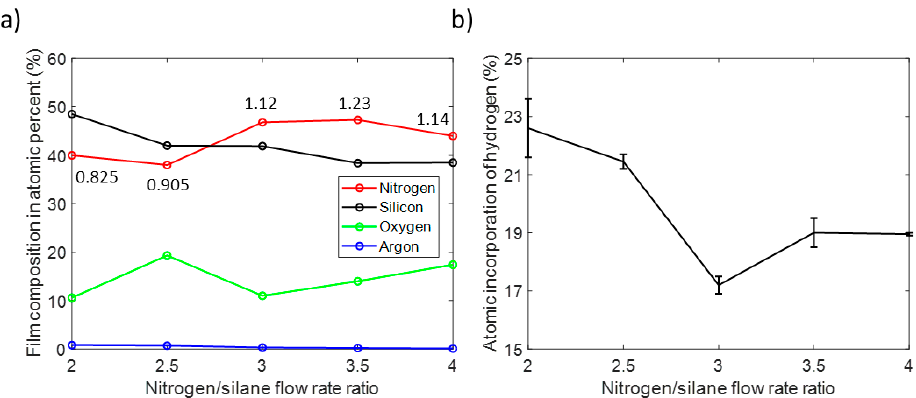
Figure 5. ( a ) Film composition determined from RBS excluding hydrogen with N/Si ratio indicated. ( b ) Hydrogen incorporation determined from ERDA before annealing. The incorporated hydrogen after annealing was measured to be below 0.1 at.% for all films. Connecting lines are to help guide the eye.